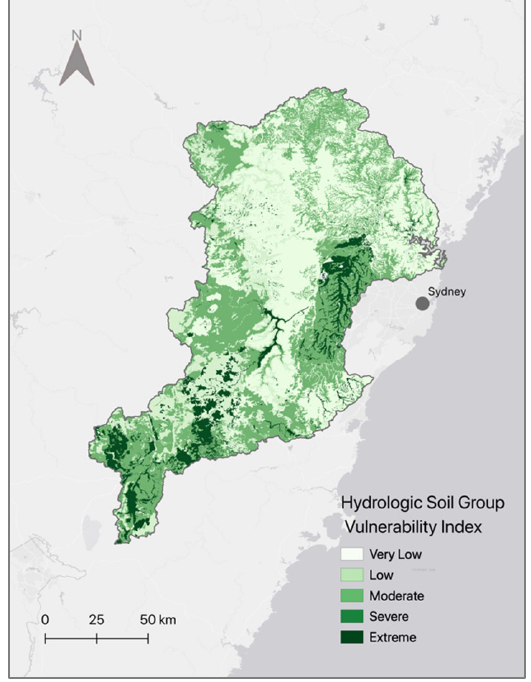
Figure 11. Map depicting Hydrologic Soil Group (HSG) vulnerability across the Hawkes ‐ bury ‐ Nepean Catchment after standardising with Fuzzy